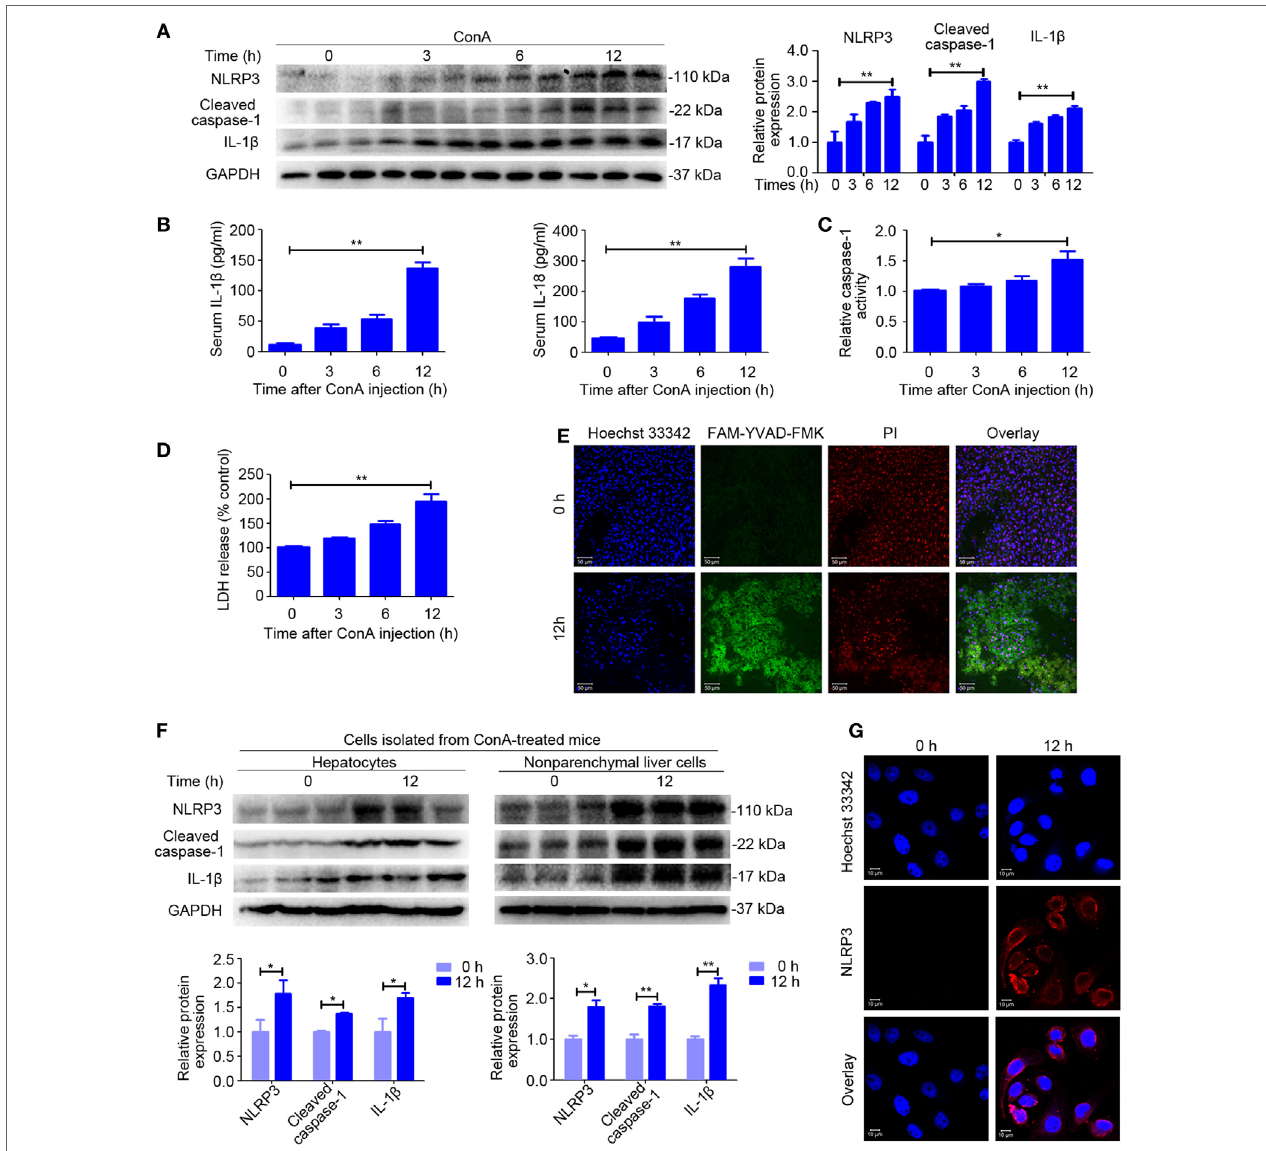
FigUre 1 | NOD-like receptor protein 3 (NLRP3) inflammasome activation and IL-1 β production in ConA-induced hepatitis. (a) BALB/c mice ( n = 6 for each group) were intravenous administrated with ConA (20 mg/kg), and sera and liver tissues were obtained following ConA injection at 0, 3, 6, and 12 h. The expression of NLRP3, Cleaved caspase-1, and IL-1 β in the livers were detected by western blot analysis. GAPDH was provided as a loading control. Each lane represented a separate animal. The blots were representative of three experiments. Densitometric values of these proteins were quantified using the Image J software. (B) Serum concentrations of IL-1 β and IL-18 were analyzed by enzyme-linked immune sorbent assay. (c) Caspase-1 enzymatic activity in the liver homogenates was measured. (D) Lactate dehydrogenase (LDH) release into serum. (e) FAM-YVAD-FMK and propidium iodide (PI) double staining of liver tissues were applied to detect pyroptosis. FAM-YVAD-FMK (green), PI (red), Hoechst 33342 (blue), Scale bars = 50 µm. (F) The protein levels of NLRP3 pathways in the primary hepatocytes and nonparenchymal liver cells isolated from ConA-treated mice were detected by western blot analysis. GAPDH was used as a loading control. Each lane represented a separate animal. Results represented three independent experiments. Quantification was presented. (g) The expression of NLRP3 in primary hepatocytes was displayed by immunofluorescence. NLRP3 (Red), Hoechst 33342 (blue), scale bars = 10 µm. The data were presented as means ± SD (Student’s t -test, * p < 0.05, ** p <